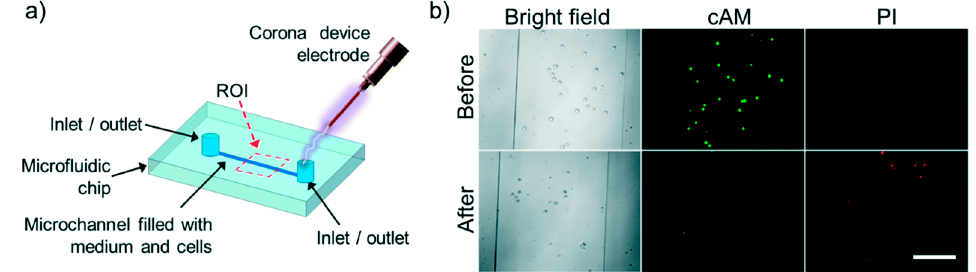
Figure 15. Electrical lysis through handheld plasma device: ( a ) schematic of the device. Cells were lysed using a hand held corona device by applying electric field at the inlet of the device; ( b ) bright field and fluorescent images of before and after of lysis of K562 cells. Reproduced with permission from [90].